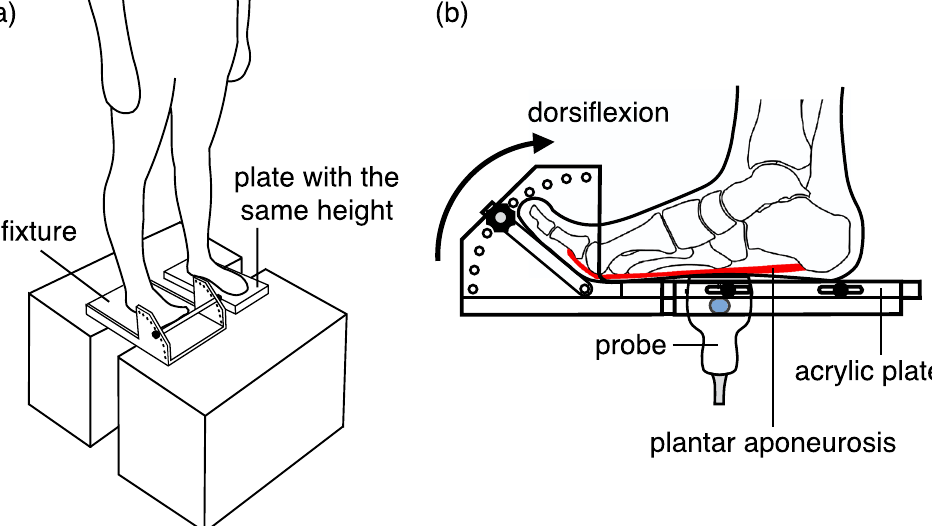
Figure 1. Schematic representation of the SWV measurement of the PA in the standing posture. The participants were requested to stand on a custom-made fixture (Takei Scientific Instruments, Niigata, Japan) with the measurement leg, and to place the other leg on a plate with the same height to maintain quiet standing posture. During standing, the MP joint was passively dorsiflexed at 0°, 10°, 20°, 30°, 40°, 50°, and 60° using the fixture ( b ). The longitudinal images of the middle site of the PA were scanned by placing the probe on the plantar surface of the foot at the navicular level through a circular hole (diameter = 65 mm) in the floor acrylic plate of the fixture that can slide along the anteroposterior direction to adjust the position of the hole with respect to the foot ( b ). SWV shear wave velocity, PA plantar aponeurosis, MP